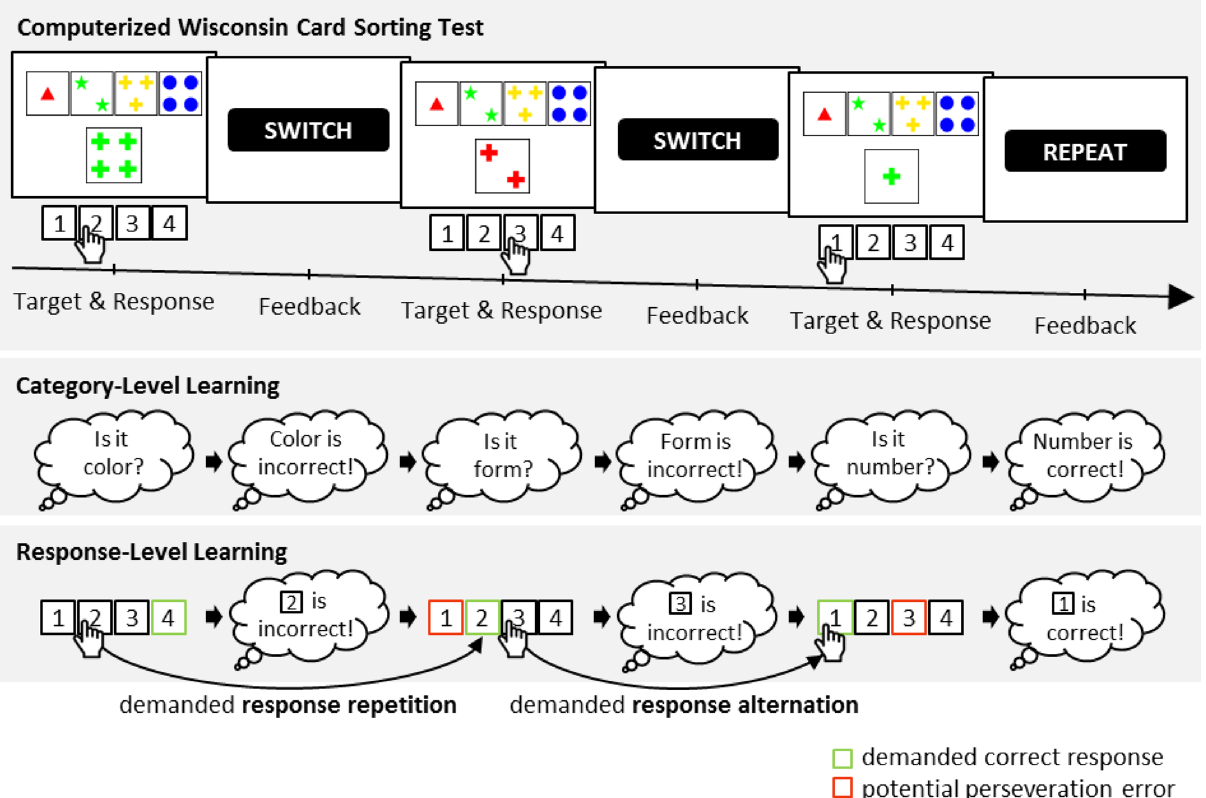
Figure 1. An exemplary outline of multiple levels of learning that contribute to card sorting performance. Computerized WCST. The present study utilizes the computerized WCST 12,35,52,53 . On the initial trial, a stimulus card (four green crosses) could be sorted according to the color category (inner left key card, response 2 ), the shape category (inner right key card, response 3 ), or the number category (far right key card, response 4 ). The color category was applied, indicated by observing response 2 . A negative feedback stimulus (i.e., the visually presented word “SWITCH”) announced that this response was incorrect, meaning that the applied category should be switched. On the next trial, the stimulus card (two red crosses) was sorted by the shape category, indicated by observing response 3 . Another negative feedback stimulus announced that response 3 was incorrect, meaning that the shape category should be switched. On the next trial, the number category was applied by pressing response 1 . A positive feedback stimulus (i.e., the visually presented word “REPEAT”) indicated that response 1 was correct, meaning that the number category should be repeated on the upcoming trials. Category-Level Learning. Participants are supposed to consider abstract categories to guide